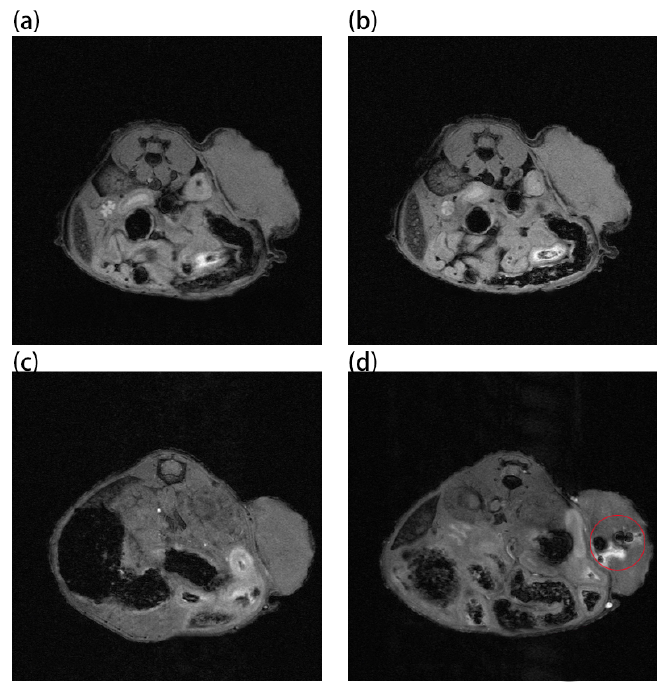
Figure 6. MR images before and after intratumor injection of Au and Au ‐ UCNPs ‐ DSPE ‐ PEG 2K in Balb/c mice, ( a , b ) are before and after injection of Au, ( c , d ) are before and after injection of Au ‐ UCNPs ‐ DSPE ‐ PEG 2K .